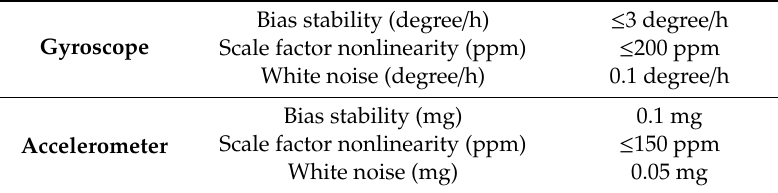
Table 1. Inertial Measurement Unit (IMU) specifications.